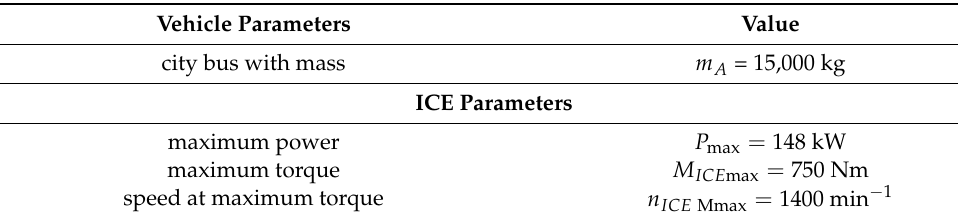
Table 1. Vehicle specification data used for